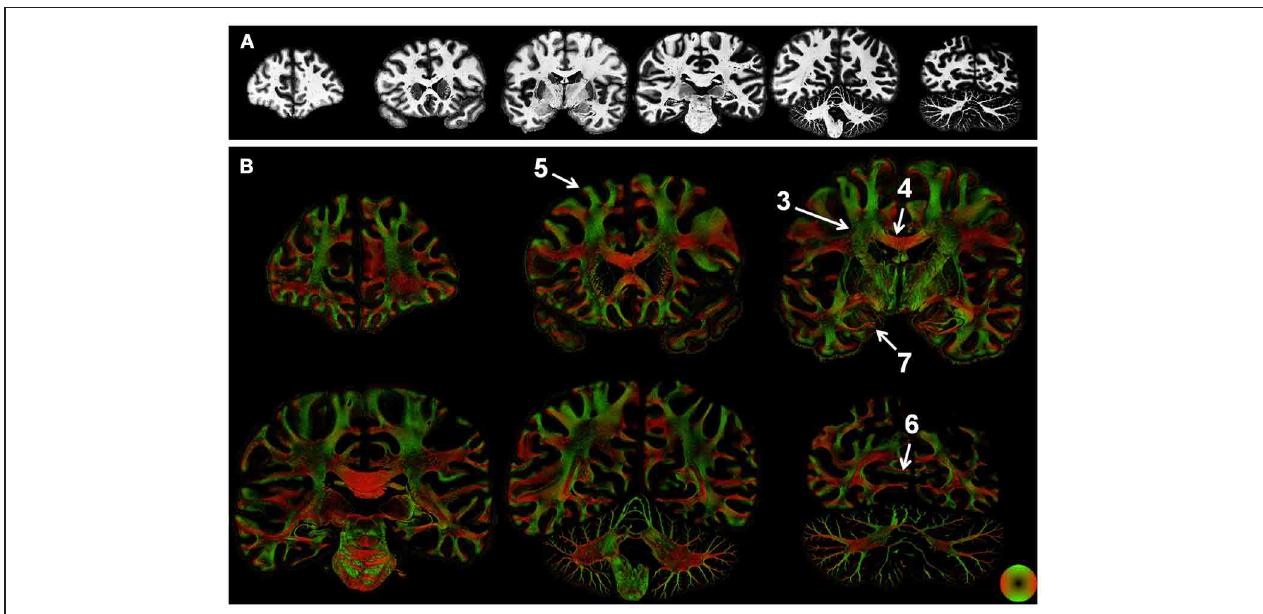
uniform in the white matter, but the DEC images highlight the intricate microstructure of white matter tracts. Numbers indicate the regions shown in greater detail in subsequent